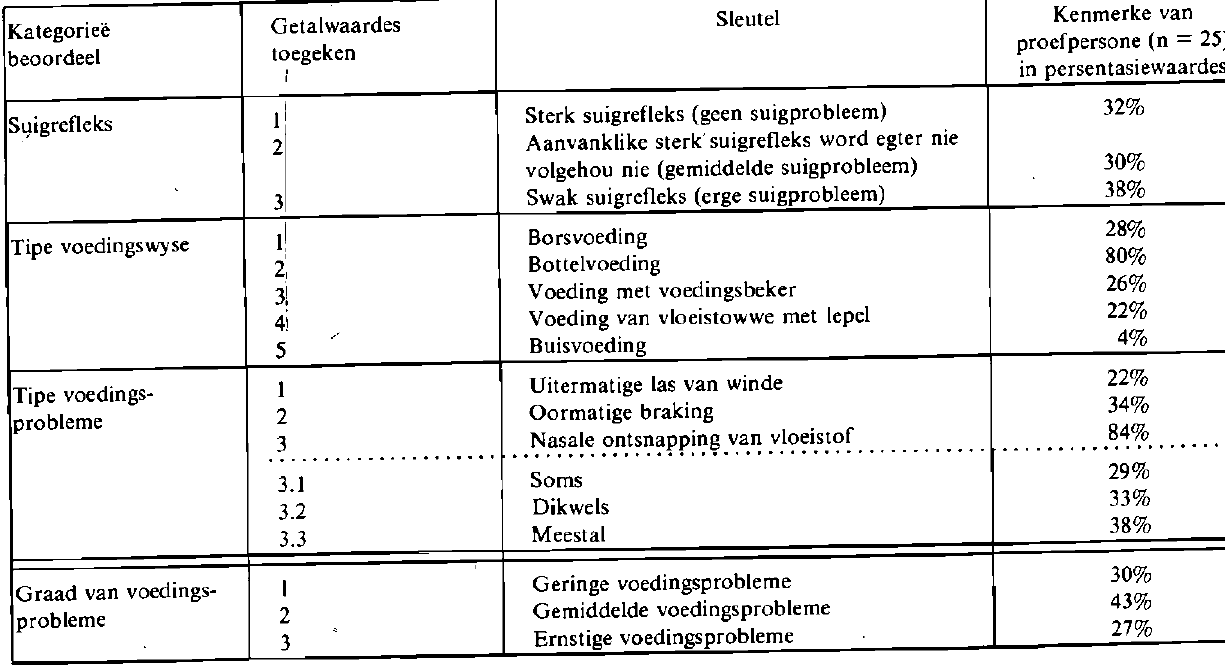
Tabel 8: Resultate van die beoordeling van die voedingsproses Kategoriee beoordeel